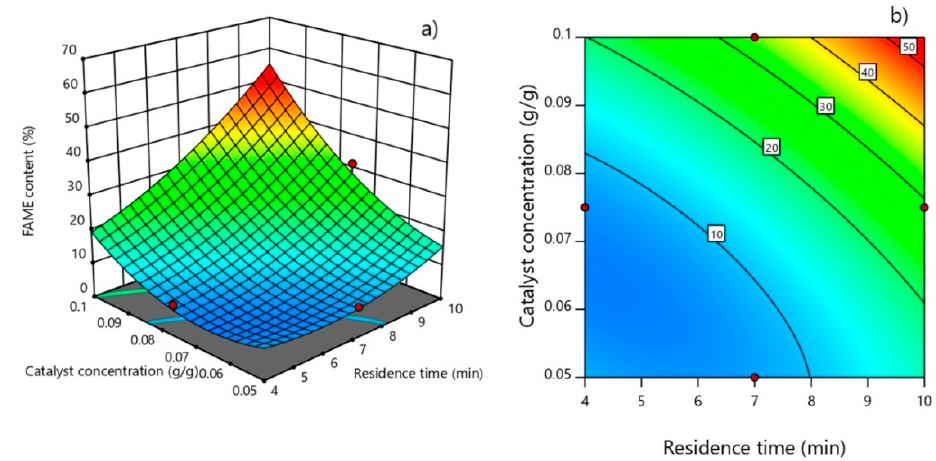
Figure 10. Response ( a ) surface and ( b ) contour plot of FAME content as a function of catalyst con- centration and residence time (60 °C, catalyst concentration of 0.1 g g -1 , the residence time of 10 min, and methanol/oil volume ratio of